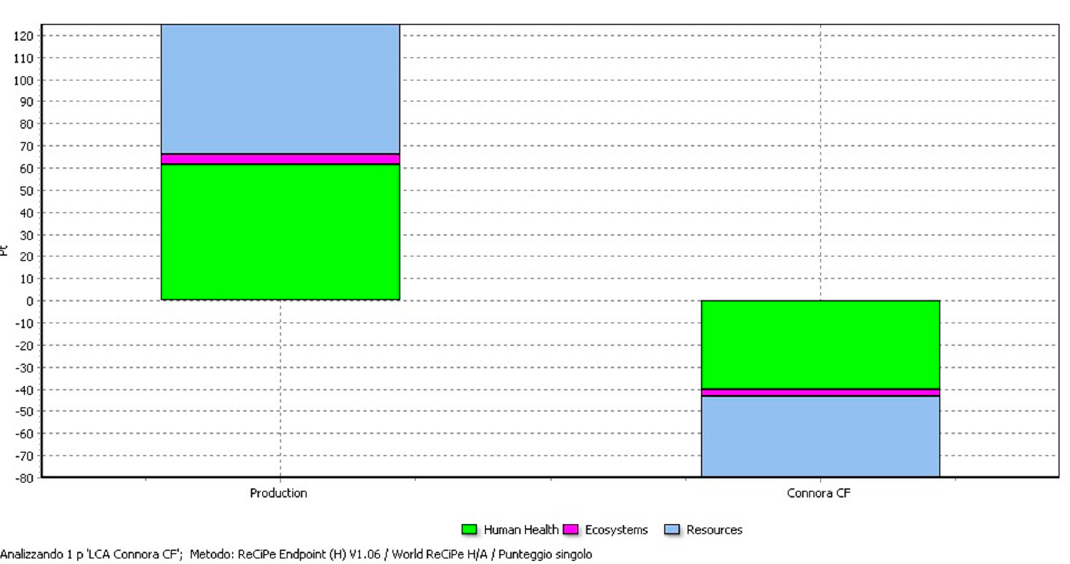
Figure 10. Damage assessment through ReCiPe Endpoint. Avoided damages on Human Health (HH), Ecosystems, and Resources are associated with the recycling process with recovery of CFs.